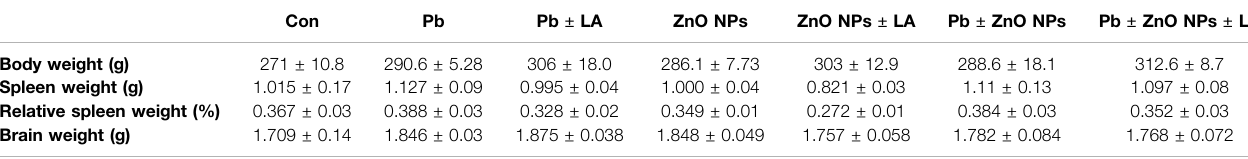
Abbreviations: Wt, weight; g, gram. All the values are expressed as mean ± SEM (n (cid:2) 4). There was no statistical signi fi cance among the groups. Relative organ weight (cid:2) weight of the organ/body weight*100.